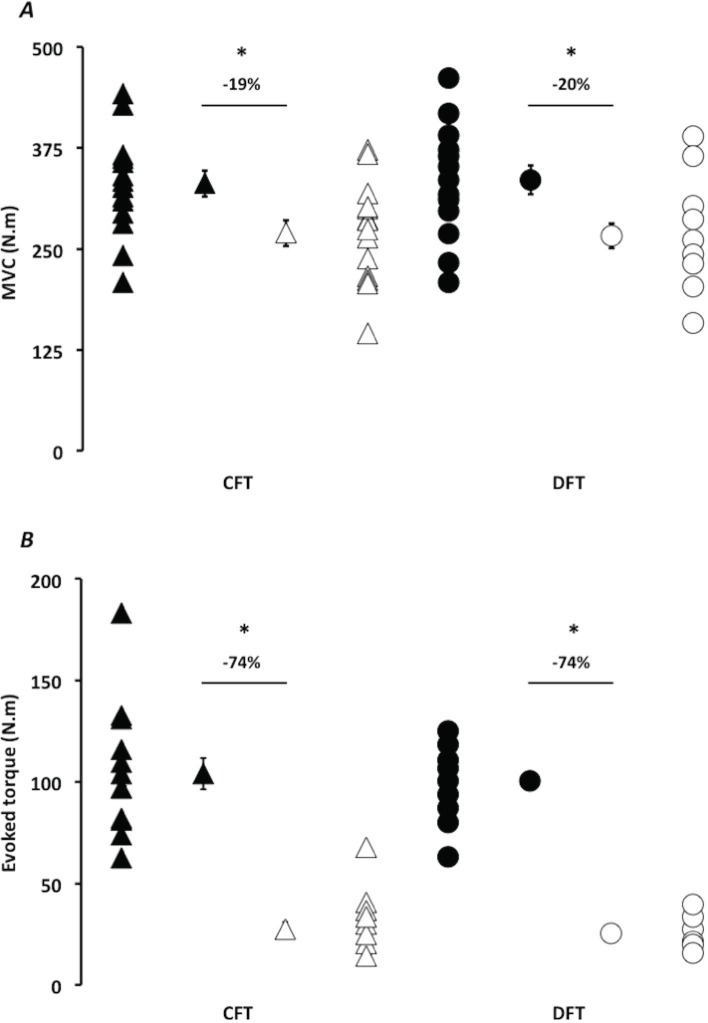
Voluntary and evoked torque in pre- and post-fatigue conditions.(A) Maximal voluntary torque (Nm) values obtained before (black symbols) and immediately after (white symbols) the constant-frequency trains program (CFT) and doublet frequency train (DFT). (B) Average torque evoked during the first 5 (black symbols) and the last 5 contractions (white symbols) of each stimulation program. Values in the inner part of CFT and DFT represented mean values ± SD Values in the outer part of CFT and DFT represented individual values. *: statistical differences between PRE and POST values (P<0.05).